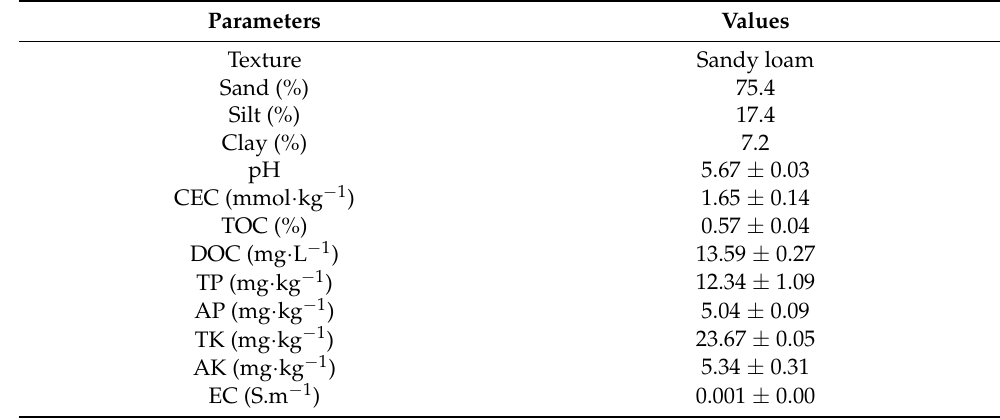
Table 1. Physicochemical properties of the soils in the experimental site. Cation exchange capacity, CEC; total organic carbon, TOC; dissolved organic carbon, DOC; total phosphate, TP; available phosphate, AP; total potassium, TK; available potassium, AK; and electrical conductivity, EC. Given are mean ± SE ( n = 6).